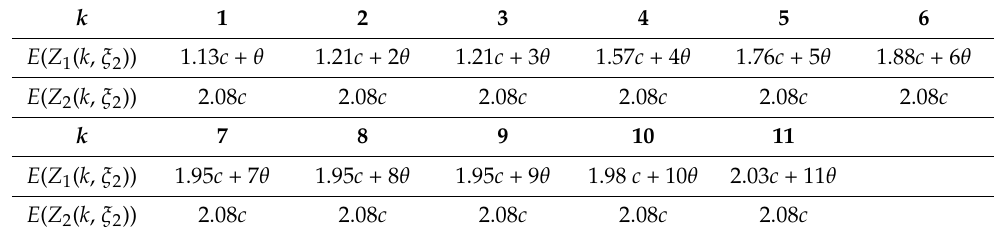
Table 9. Not loaded with average cost.